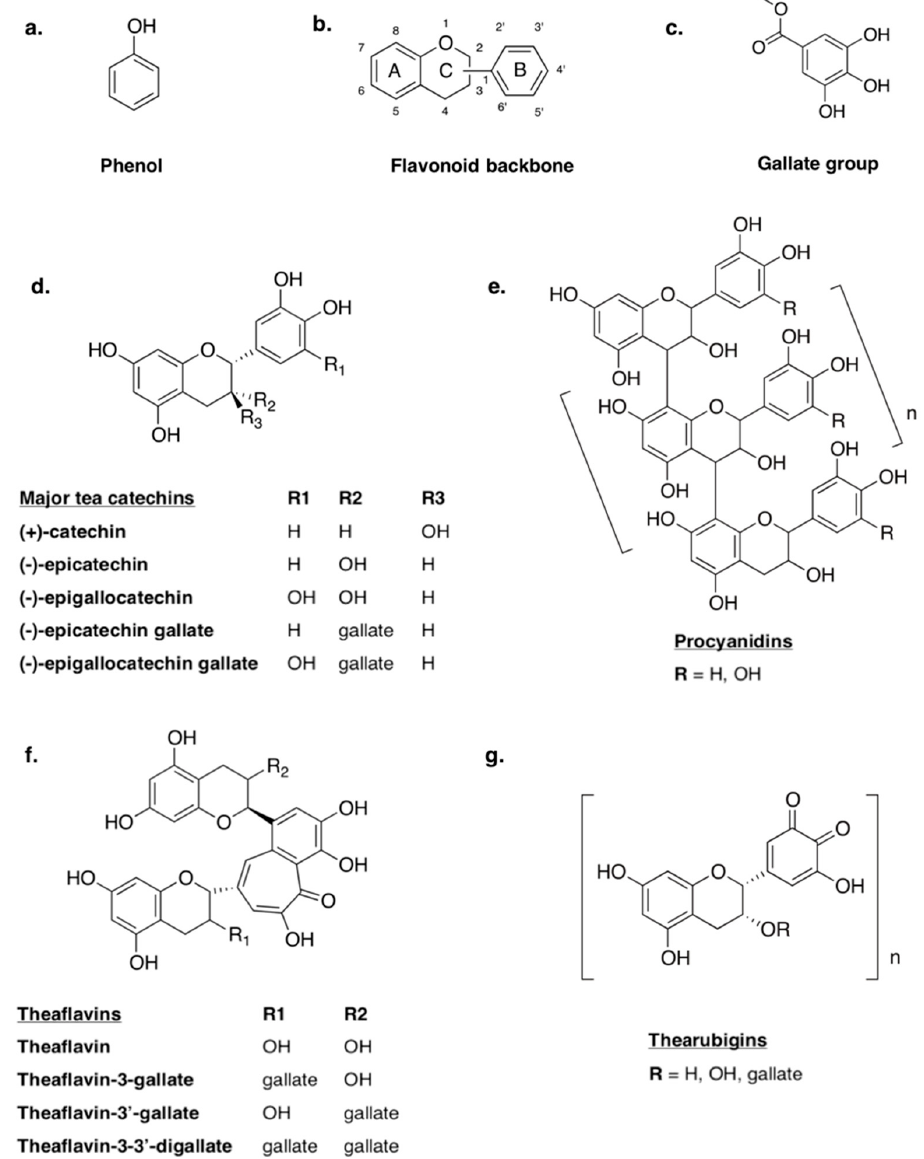
Figure 1. Structures of basic flavonoids and polymerization products: ( a ) a basic phenol, ( b ) the common flavonoid backbone, ( c ) a gallate group, ( d ) major tea catechins, ( e ) the standard molecular structure of B-type procyanidins, ( f ) major tea theaflavins and ( g ) the standard molecular structure of thearubigins.